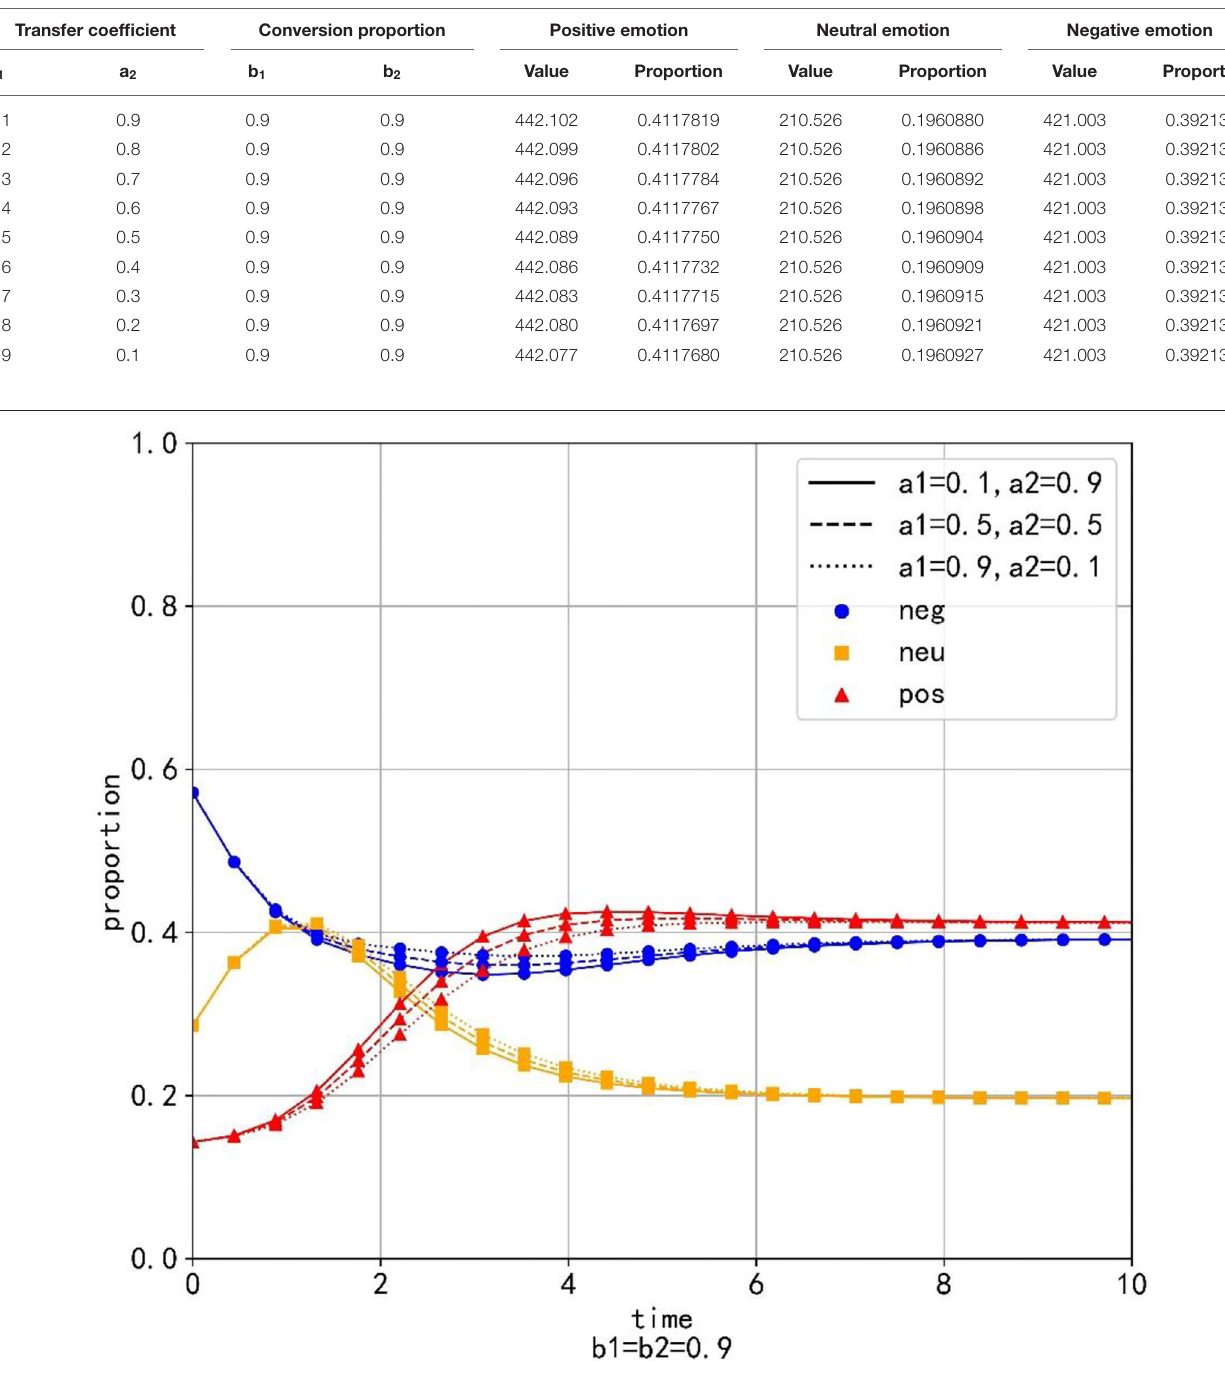
the equilibrium point under different values of each parameter, the values of parameters a 1 , a 2 , b 1 , and b 2 in each simulation